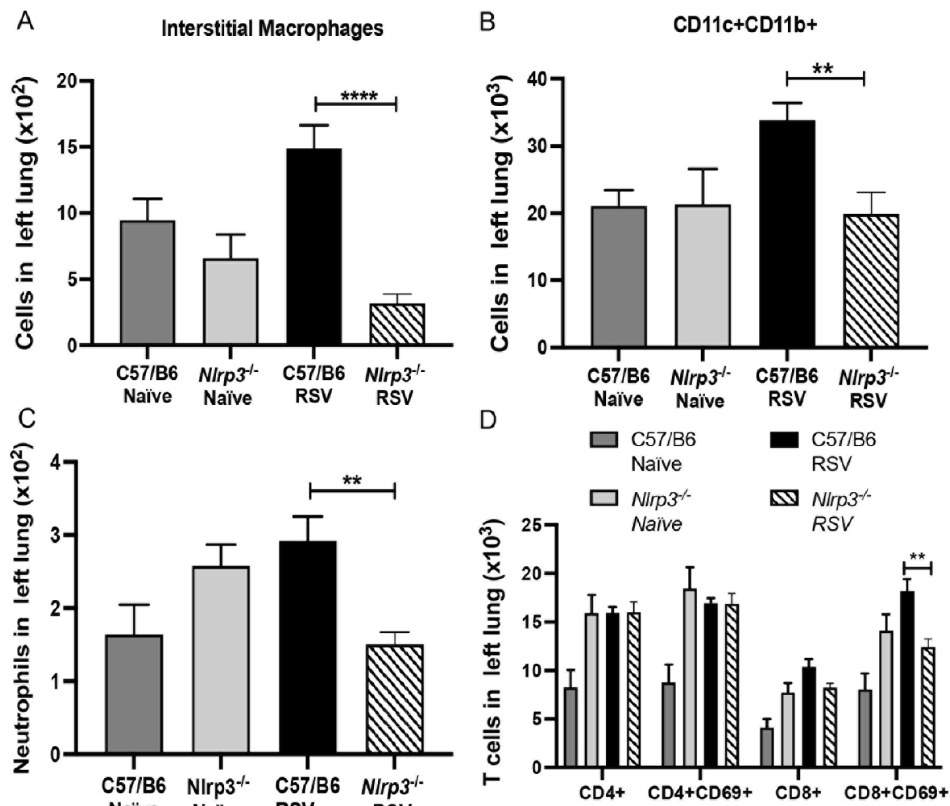
Figure 6. Diminished RSV airway inflammation in Nlrp3−/− neonate mice. ( A ) Neonatal Nlrp3−/− or C57BL/6 mice were infected with RSV. Flow cytometry of the lung leukocytes ( A ) Interstitial macrophages ( B ) CD11c+CD11b+ antigen-presenting cells ( C ) Neutrophils ( D ) T cells. Data represent the Mean ± SEM from 4 to 5 mice (experimental repeats 2). ** p ≤ 0.01, **** p ≤ 0.0001.